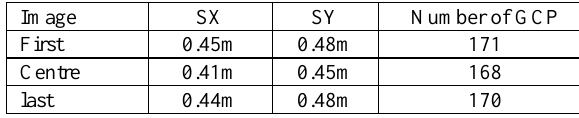
Table 2: Standard deviation of ground control points based on